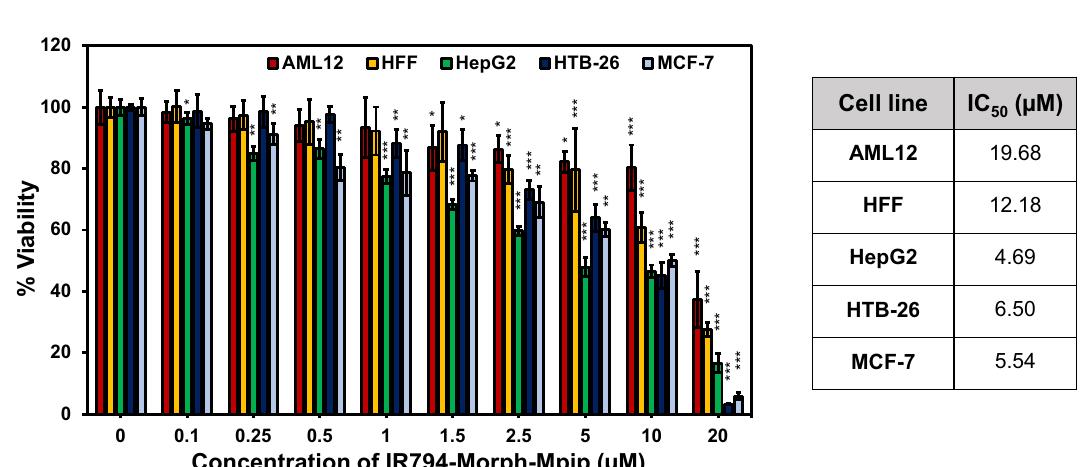
Figure 5. Relative viabilities of various cell lines after exposure to IR794-Morph-Mpip at various concentrations (0 ‒ 20 μM) for 6 h. Statistical analysis is based on Pair Student’s T-test analysis (*P < 0.05, **P < 0.01, ***P < 0.001) which compared between the treatment and the control of each cell line. Table shows IC 50 of IR794-Morph-Mpip treated on different cell